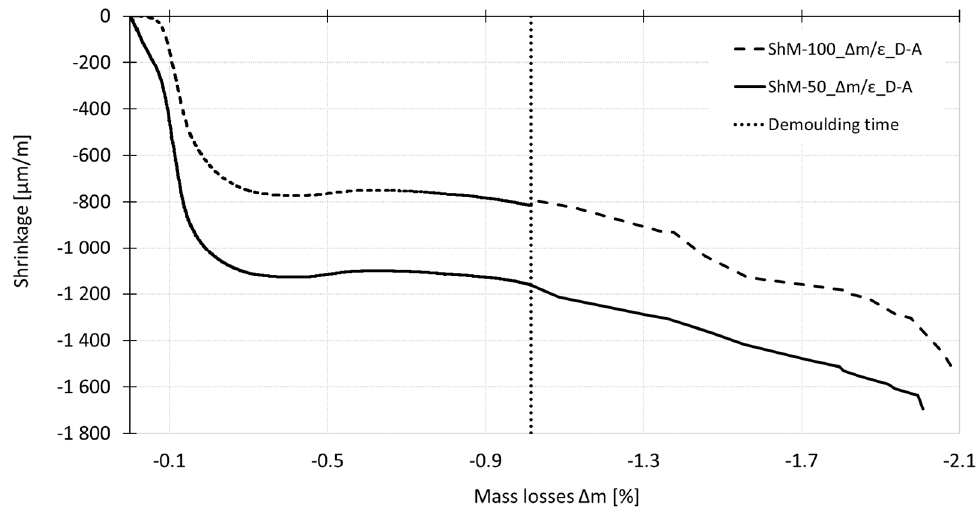
Figure 12. Relationship between shrinkage ( ε ) and mass losses ( ∆ m) determined for specimens of different dimensions cured under dry air conditions.